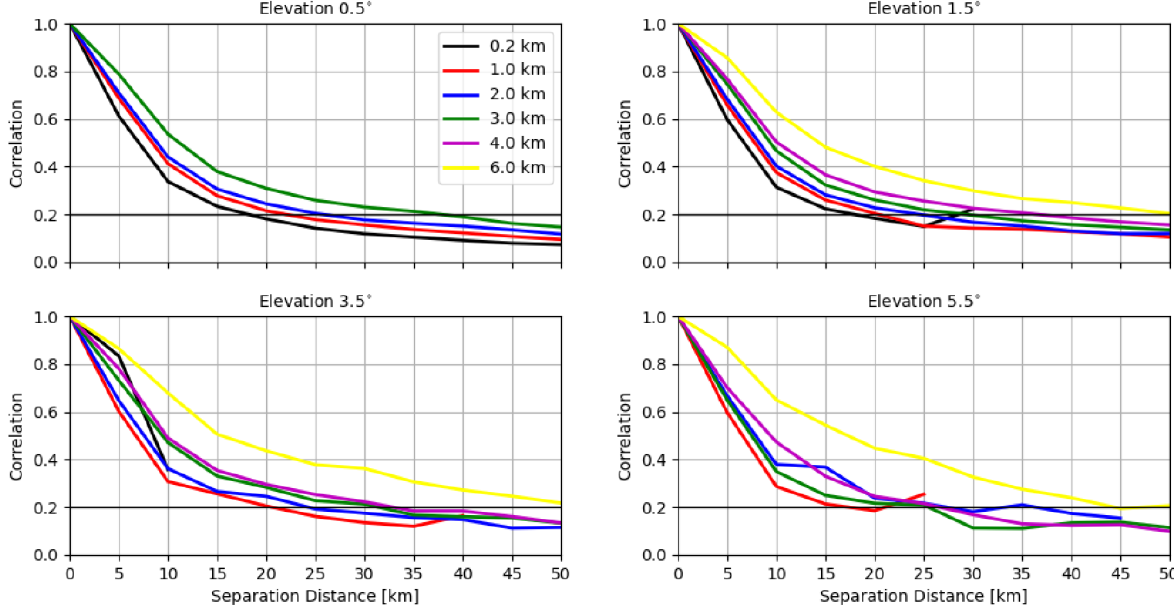
Figure 10. The estimated horizontal correlations for the OE of reflectivity data ≥ 5dBZ for elevations of 0 . 5, 1 . 5, 3 . 5 and 5 . 5 ◦ at heights of